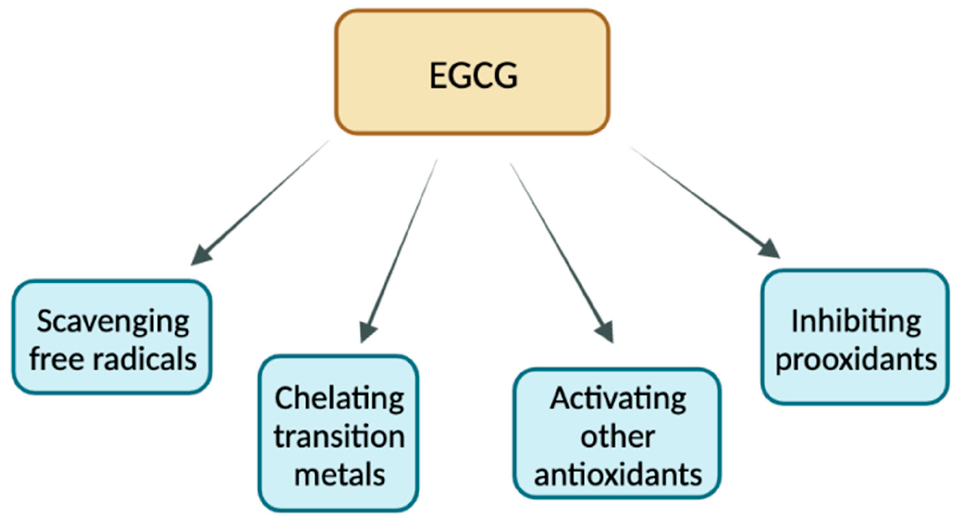
Figure 3. Antioxidant effects of EGCG.